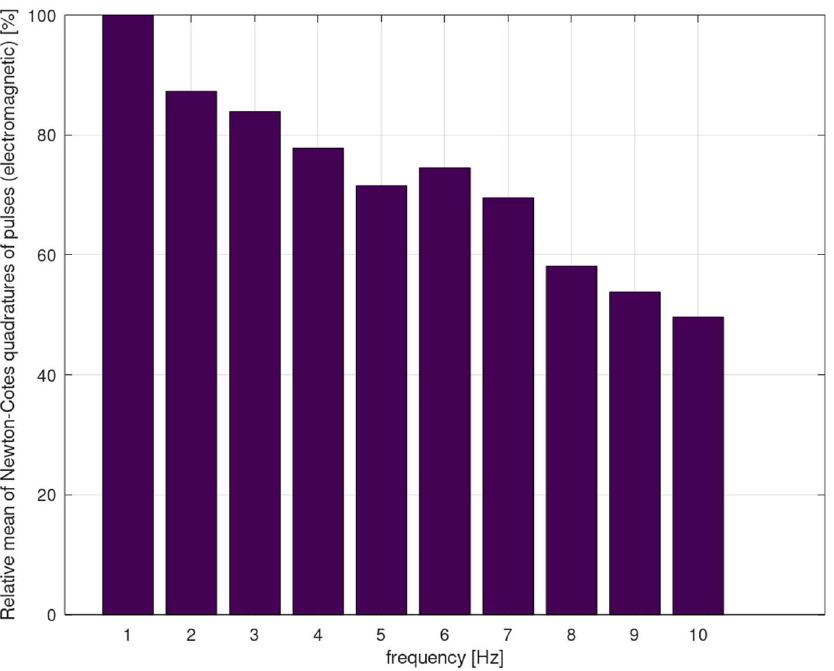
Figure 9. Energy flux density (expressed as quadrature of pulse) and the operating frequency for electromagnetic applicator—measured by hydrophone.